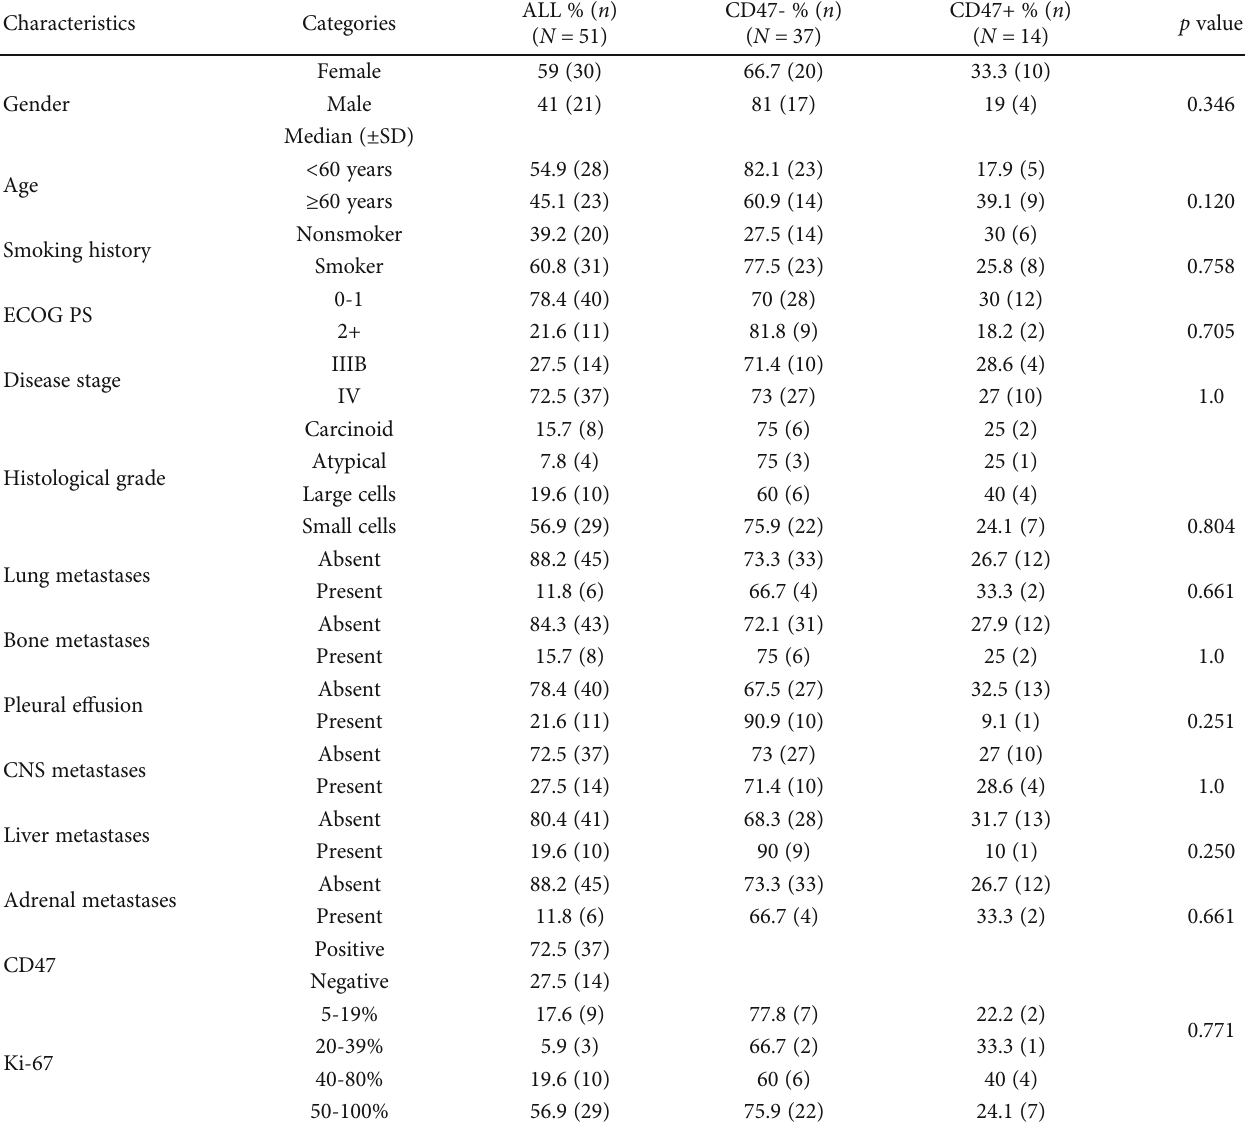
Table 1: General characteristic of the entire population according to CD47 expression (positive vs.